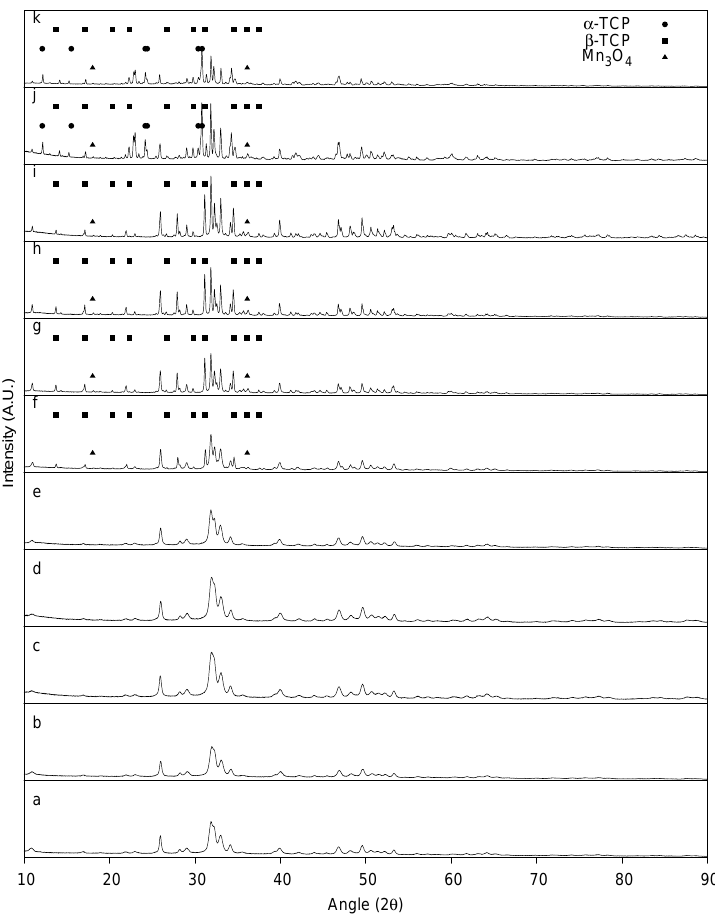
Figure 3. Powder XRD pattern of as-synthesized MnHA ( a ) and MnHA heat-treated at: 400 °C ( b ); 500 °C ( c ); 600 °C ( d ); 700 °C ( e ); 800 °C ( f ); 900 °C ( g ); 1000 °C ( h ); 1100 °C ( i ); 1200 °C ( j ); and 1300 °C ( k ). Non-labeled peaks correspond to observed reflections from pure HA.